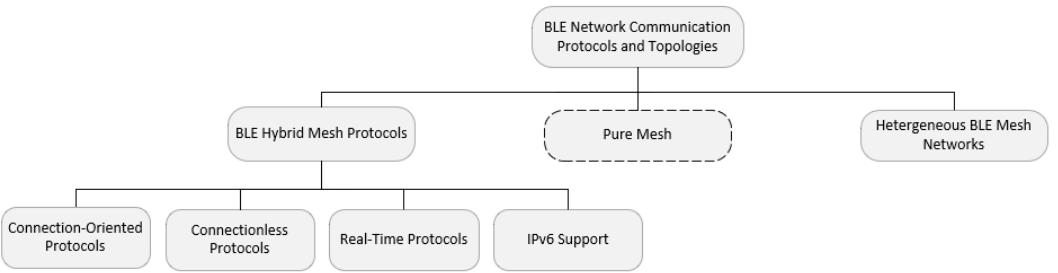
Figure 2. Classification of BLE Communication